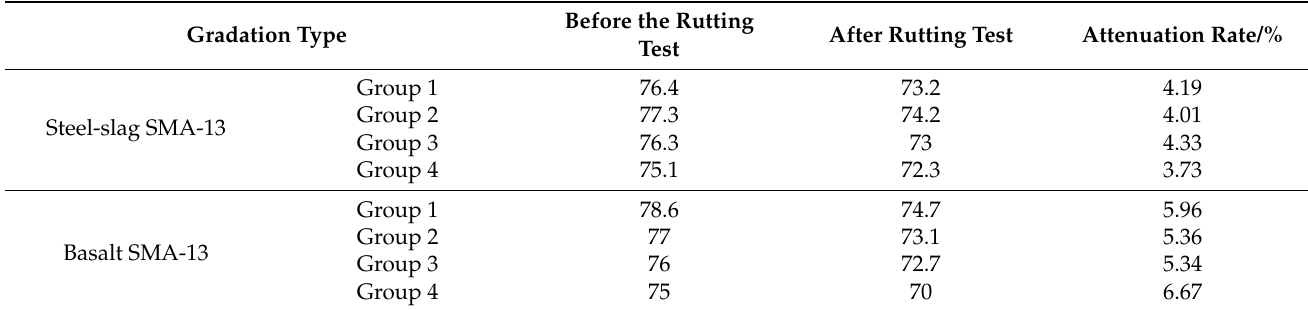
Table 9. British pendulum values in the